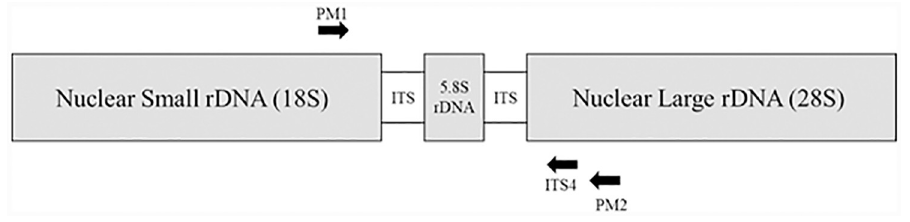
Fig 7. Primer map indicating nested PMITS1/PMITS2 and PMITS1/ITS4 amplified regions used in this